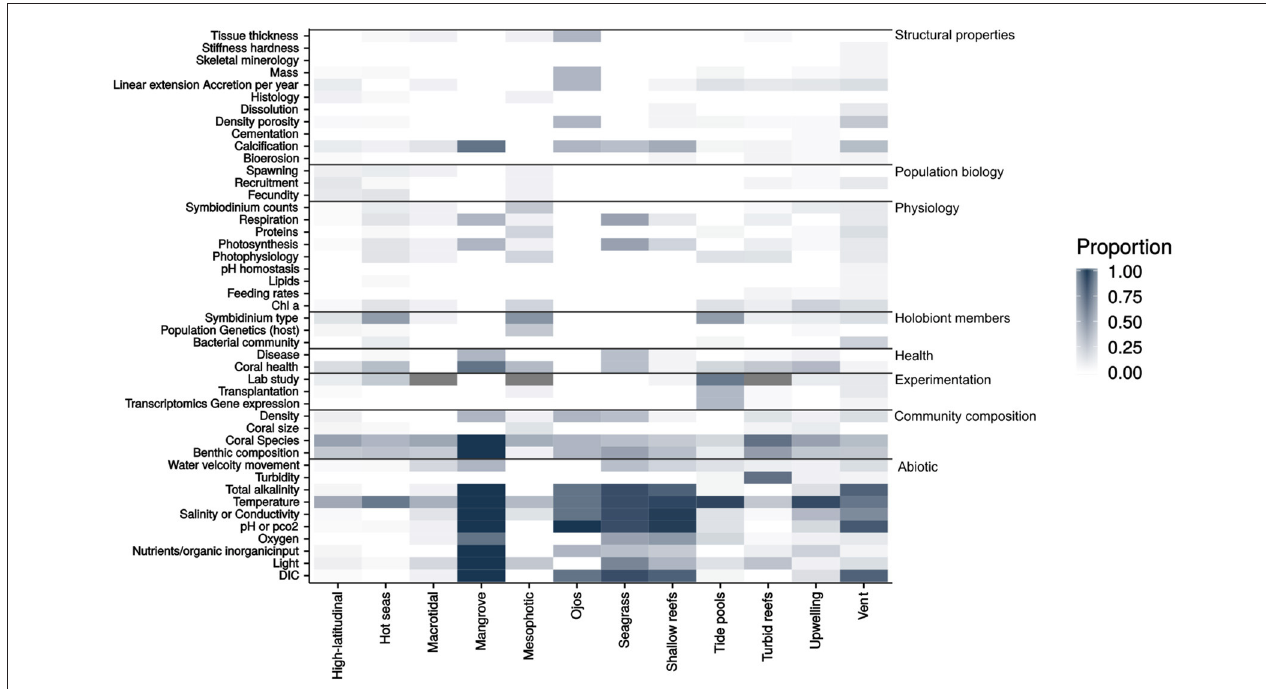
FIGURE 1 | A heat-map showing the research parameters measured within the 285 studies reviewed for the quantitative synthesis. The heat-map is based off the proportion of studies for each environment that researched the given parameter. Number of studies contained in the synthesis per environment: High-latitudinal = 70, Hot seas = 34, Macrotidal = 17, Mangrove = 3, Mesophotic reef = 15, Ojos = 3, Seagrass = 6, Shallow reefs = 21, Tide pools = 21, Turbid reefs = 40, Upwelling = 35, Vent = 20.